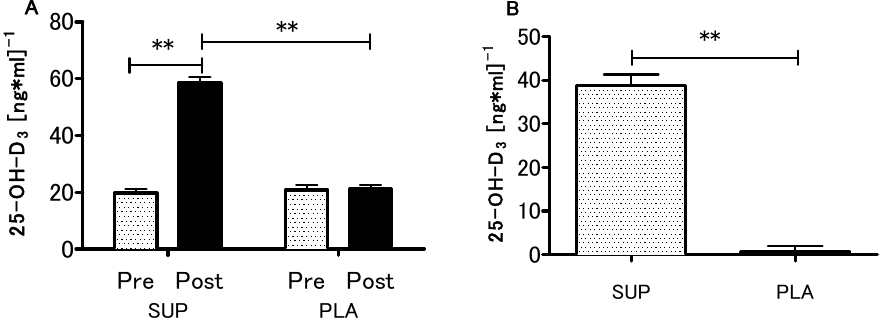
between supplemented (SUP) versus placebo (PLA) deltas (post-pre) ( B ). Values are means. Error bars indicate ± SEM. ** = p < 0.01.